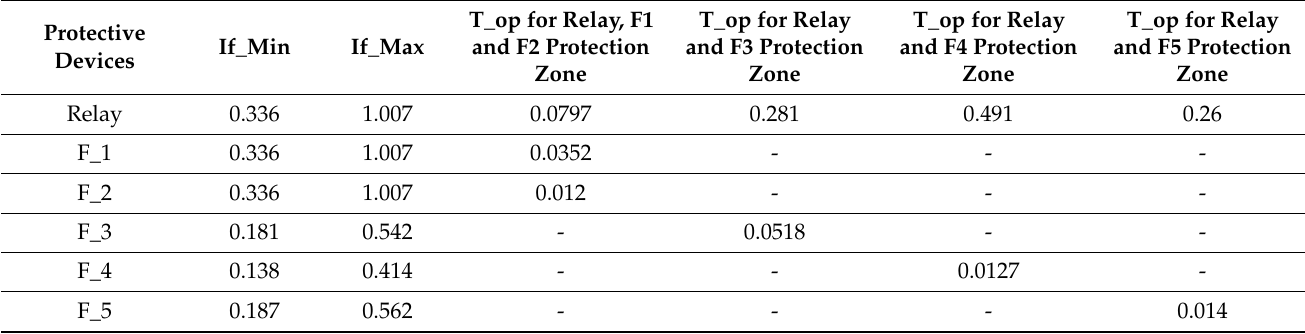
Table 3. Restored network protective device condition without protection